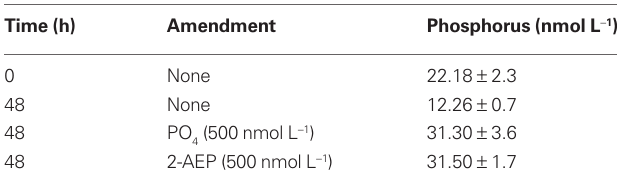
Table 2 | Particulate organic phosphorus content of BATS surface water samples amended with 2-AeP and inorganic phosphate.